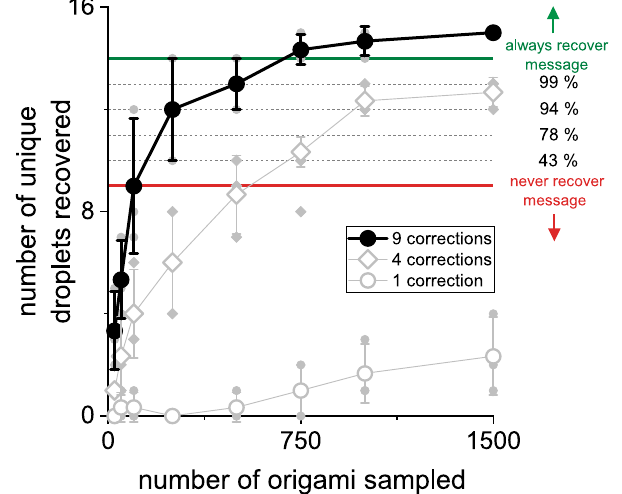
Fig. 4 Number of dNAM origami required to recover the message. The mean number of unique dNAM origami correctly decoded for randomly selected subsamples of decoded binary strings are shown. The analysis was broken out by the number of errors corrected for each origami, three examples are plotted (1, 4, and 9). Black fi lled circles depict the mean results for nine error corrections, which is the ‘ maximum allowable number of errors ’ parameter used in the decoding algorithm for all other analysis reported here. The horizontal lines indicate the probability of recovering the message with different numbers of unique droplets. With fourteen or more droplets, the message should always be recovered (thick green line, and above indicates 100% chance of recovery) and with nine or fewer droplets the message will never be recovered (thick red line and below indicates 0% chance of recovery). Mean values for three experiments are shown. Error bars indicate ±SD. Individual data points are plotted behind as smaller gray symbols.